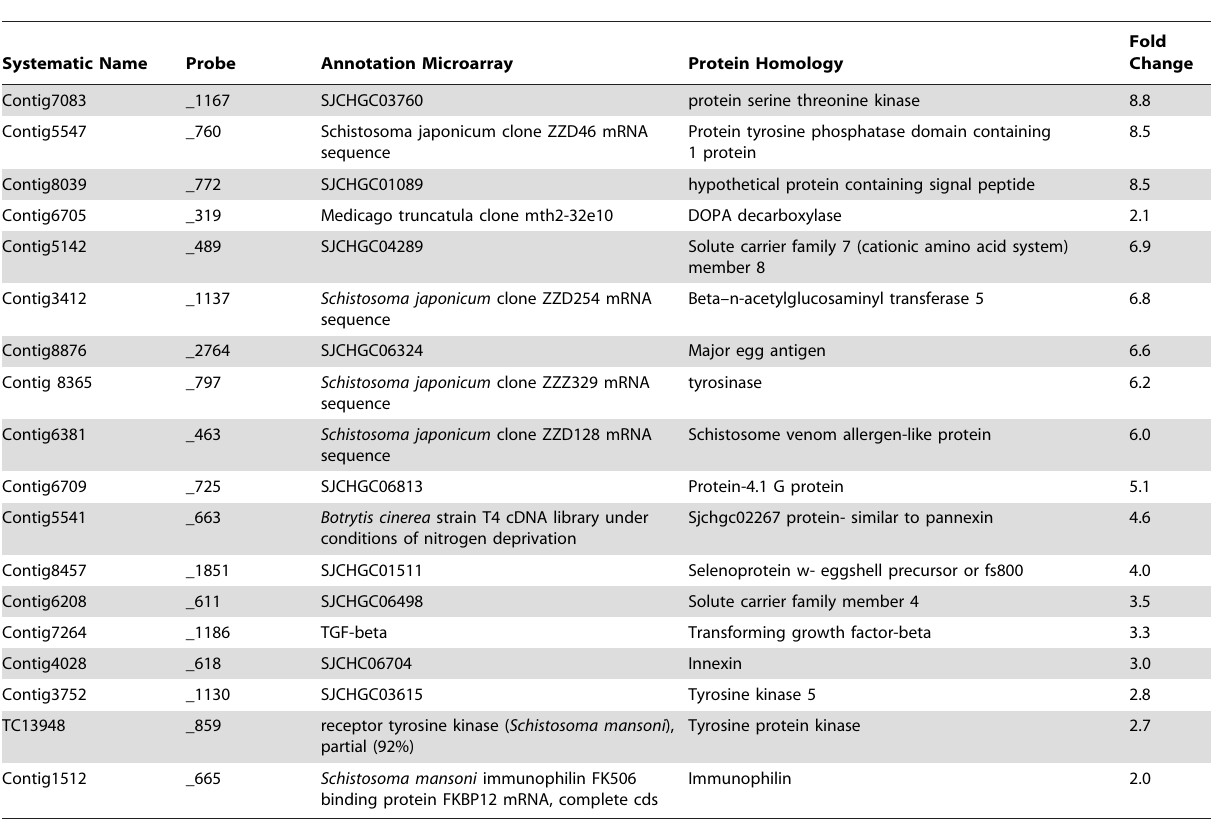
Table 3. Examples of differentially expressed genes of the vitelline glands, normalised to signal intensity of the gastrodermis.